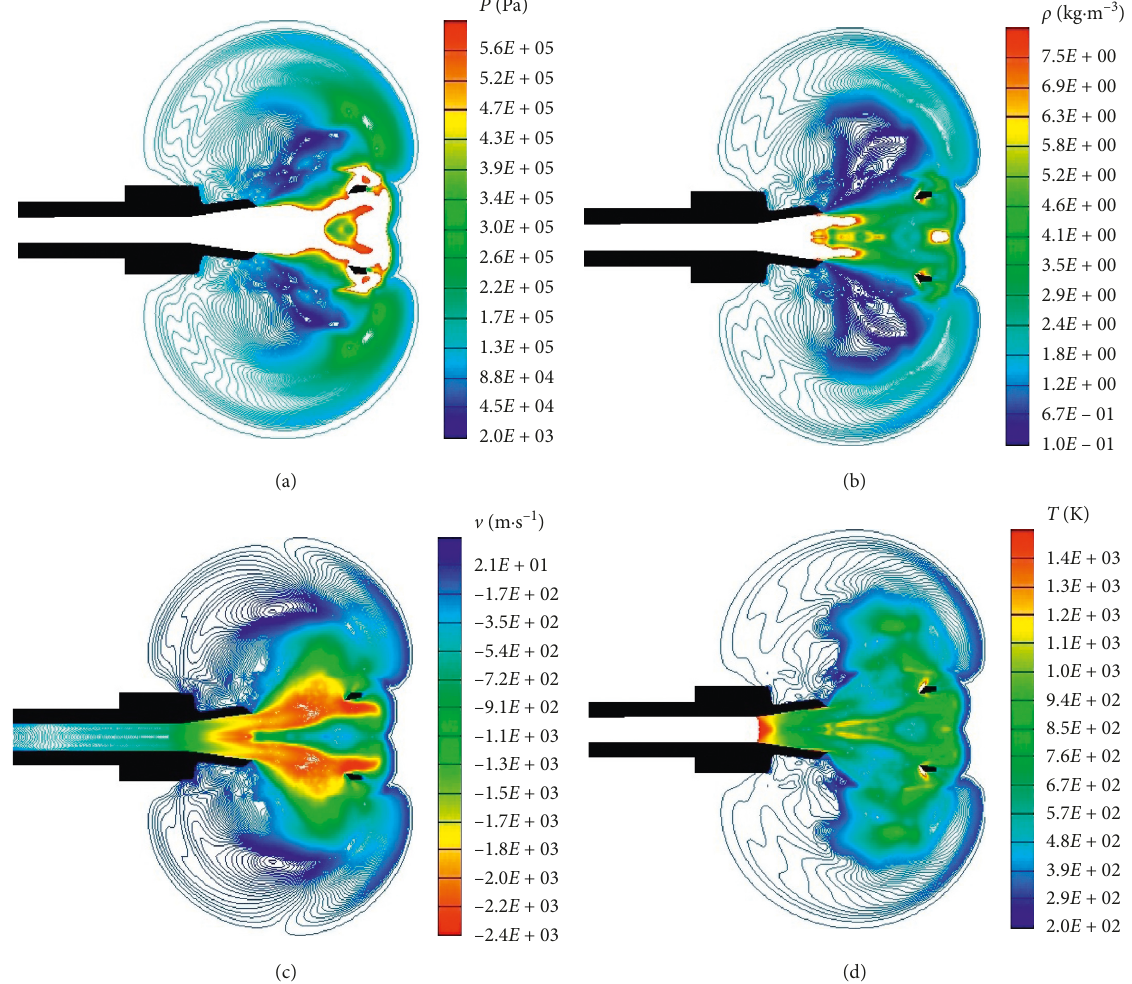
Figure 14: Muzzle flow field at t � 0.5ms. (a) Pressure contours. (b) Density contours. (c) Velocity contours. (d) Temperature contours.